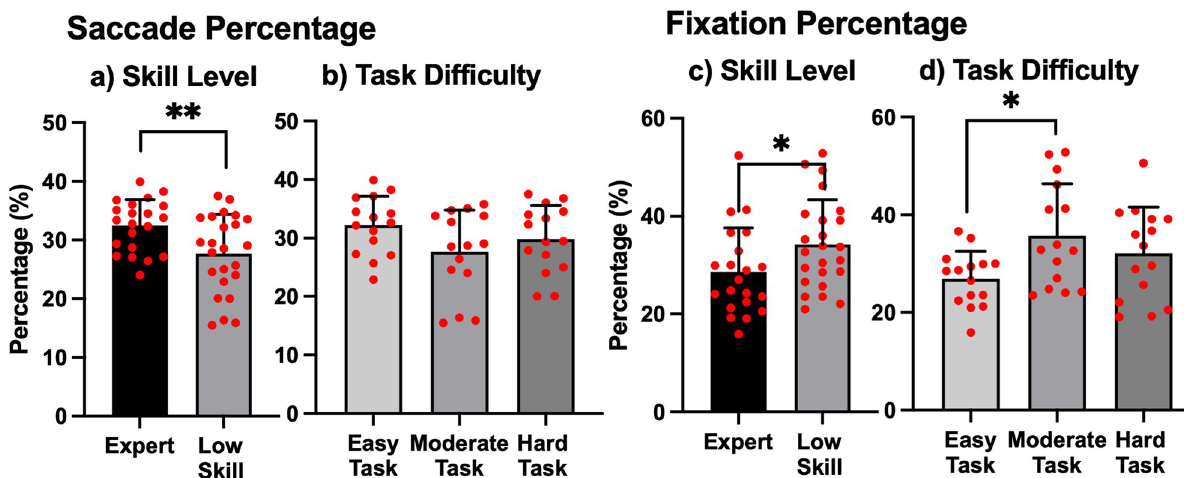
Fig 7. Classification of gaze movement. Each data shows the percentage that each gaze movement (saccade and fixation) occupies when performing a task by applying the Eye Movement Detector in Pupil-Player. Each red circle represents an individual data point. The significance level was set at �� p < .01 for saccade and � p < .05 for fixation.